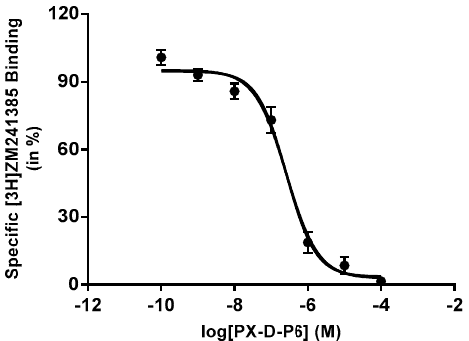
Figure 4. The sigmoidal concentrations–response curve of specific [3H]ZM241385 binding at human A2AR expressed in HEK293. The A2AR proteins were incubated with the radiolabelled compound for 30 min and exposed to different concentrations (10 − 4 , 10 − 5 , 10 − 6 , 10 − 7 , 10 − 8 , 10 − 9 , 10 − 10 M) of the compound PX-D-P6 . Results are expressed as the percentage of the control binding. The meaning of 100% is that A2A receptors of incubating membranes are all bonded with [3H]ZM241385, and binding rate of test compounds close to zero. The experiments were performed in duplicate and the values are displayed as mean ± SD.